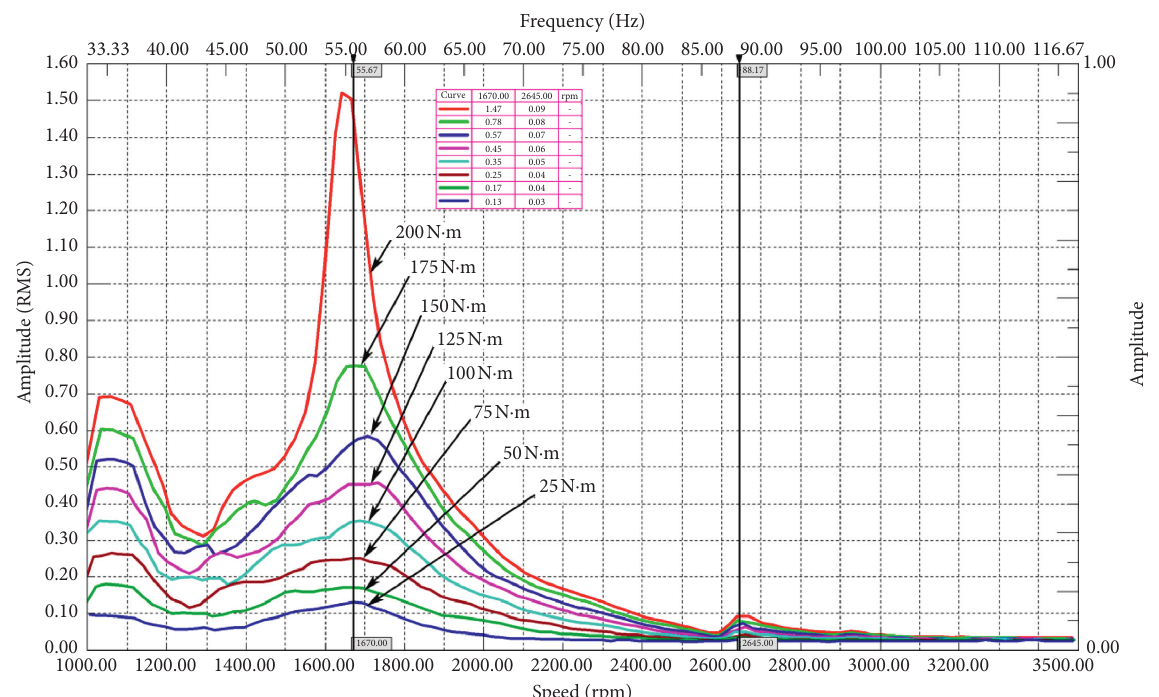
Figure 12: Amplitude-frequency responses of torsional vibration for input end of rear axle at different torque